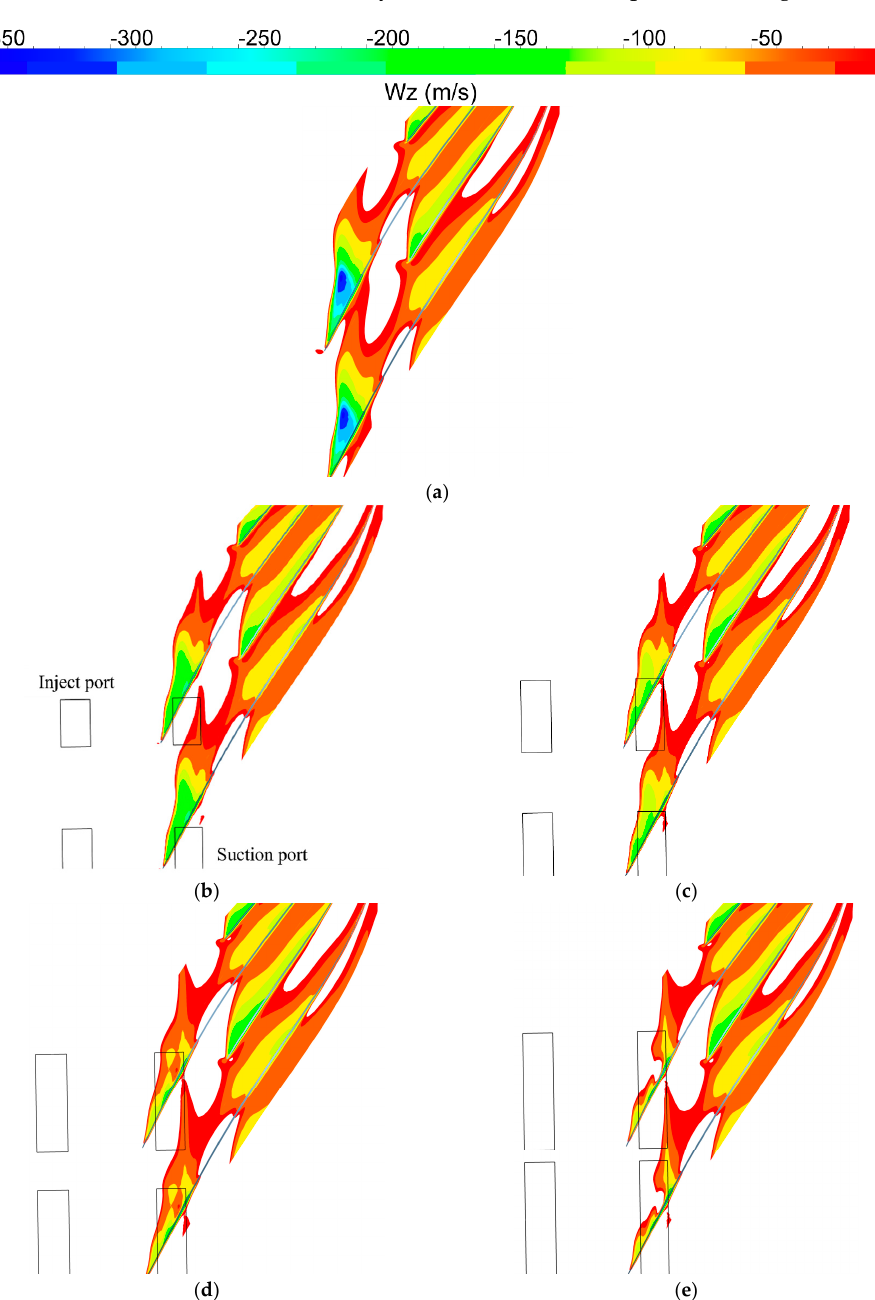
Figure 14. The axial velocity distribution at 50% τ . ( a ) SW. ( b ) SRCC0.36. ( c ) SRCC0.54. ( d ) SRCC0.72. ( e ) SRCC0.9.